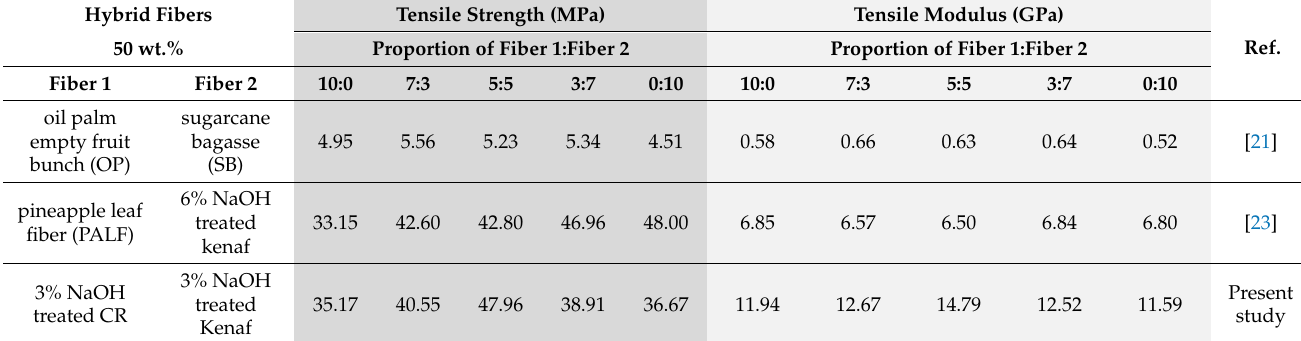
Table 5. Hybridization of fibers phenolic composites on tensile properties.